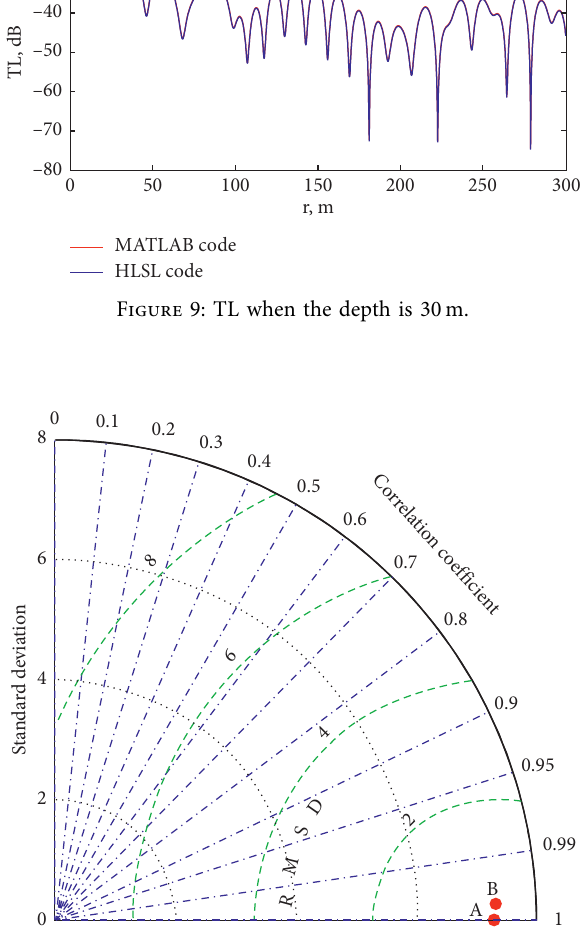
Figure 10: Taylor diagram of the HLSL code (point B) and MATLAB code (point A). The correlation coefficient is 0.9993, and the root mean square is 0.2811. Table 1: Computer times of MATLAB code, HLSL code, and C# code.